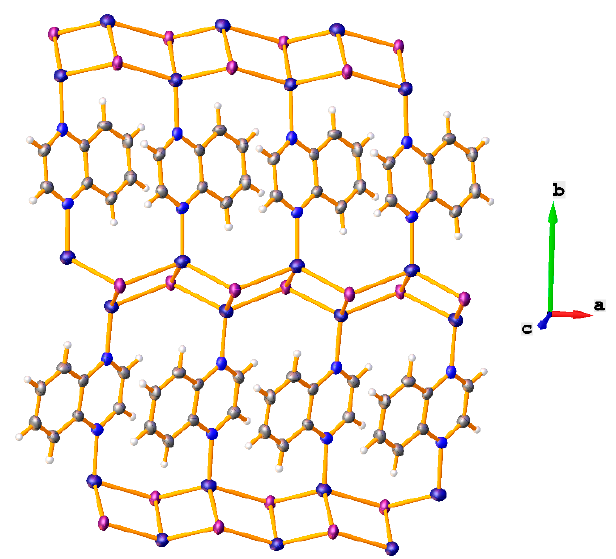
Figure 2. View of the stacking 2D layers along the c -axis ( upper ) and view of the staircase motif parallel to the a -axis ( lower ) for the complex [(CuI) 2 (Quin)].